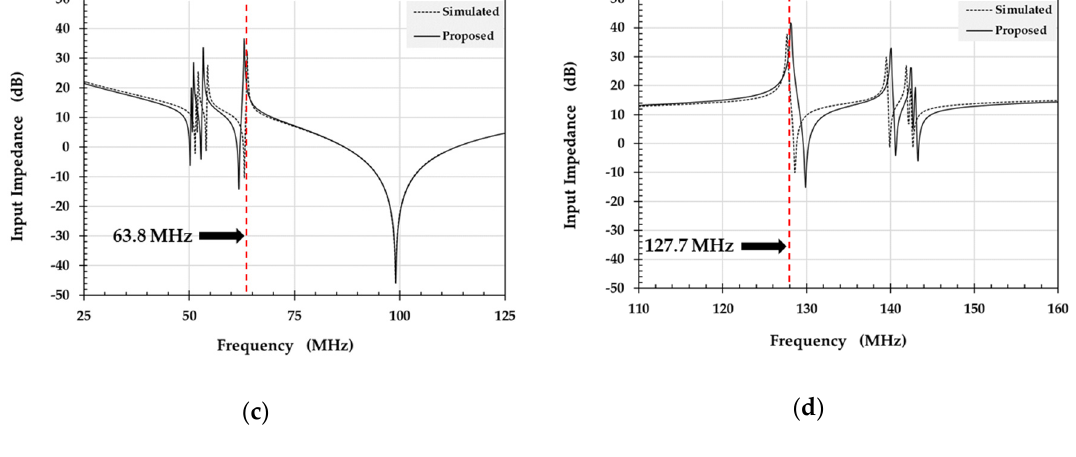
Table 4. Input impedance Z ER_p of the designed birdcage RF coils at dominant resonance frequency and the corresponding lumped components of the matching circuit for 1.5 T and 3T MRI systems.